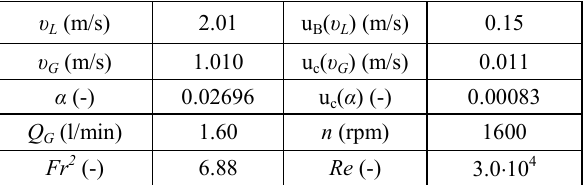
Table 1. Basic parameters of water and air flow for the analyzed experiment: υ L – water velocity, u B ( υ L ) – uncertainty type B of water velocity, υ G – air velocity, u c ( υ G ) – complex uncertainty of air velocity, α – void fraction, u c ( α ) – complex uncertainty of void fraction, Q G – gas expense, n – rotation velocity of pump, Fr 2 – Froude number, Re – Reynolds number.